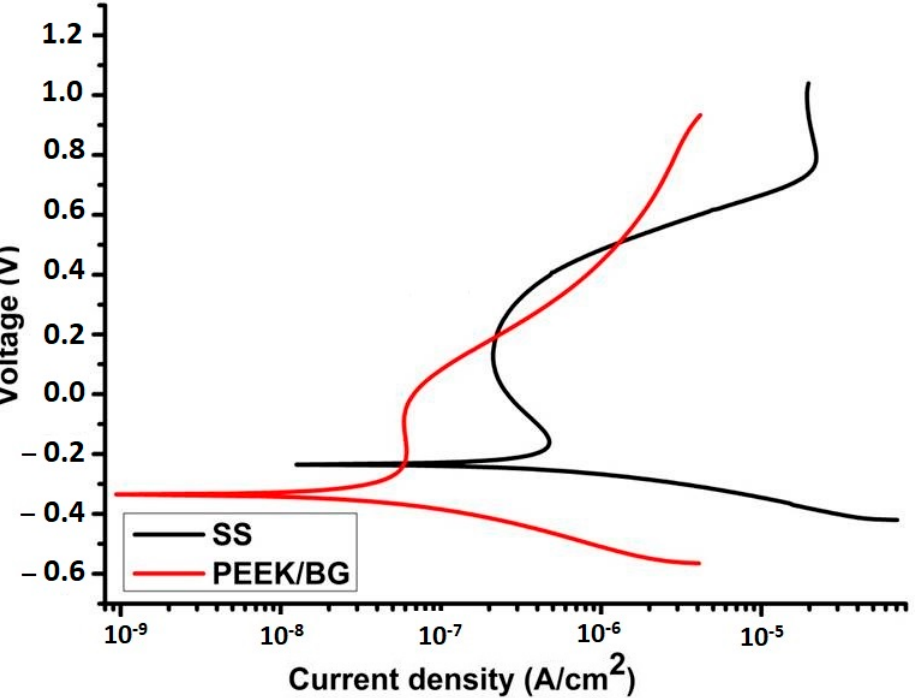
Figure 23. Polarization curves obtained by using Dulbecco’s modified eagles medium (DMEM) at